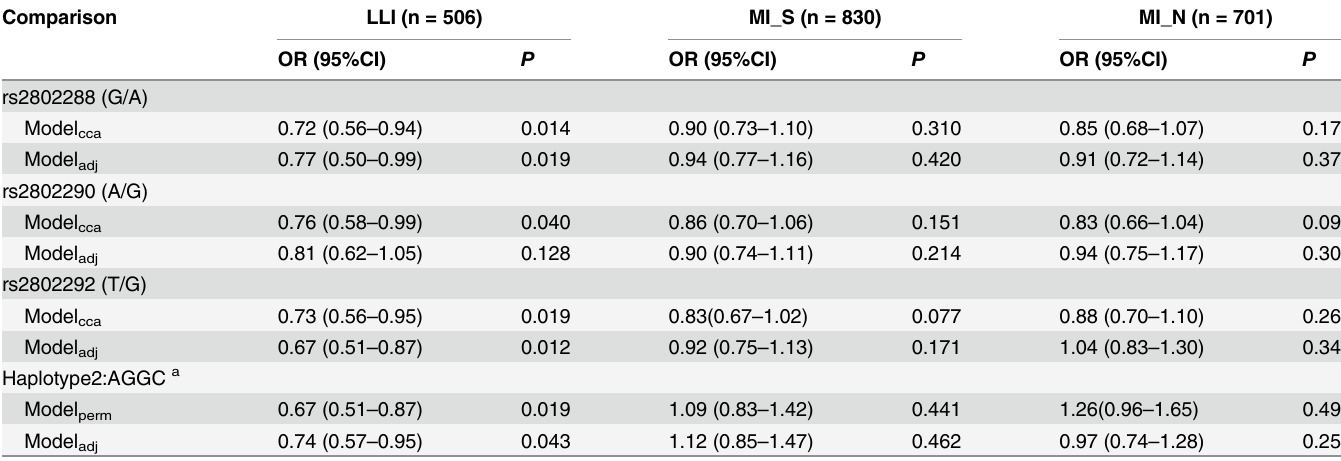
Table 3. Comparisons of effects on risk of FH between LLI and middle-aged